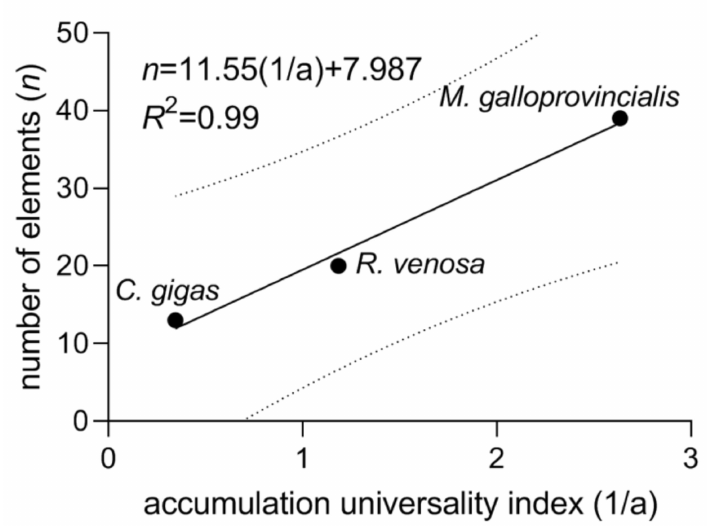
Figure 5. Number of elements with the largest shares among the three mollusks correlated with the element accumulation universality index. Solid line: linear fit; dotted lines: 90% prediction band